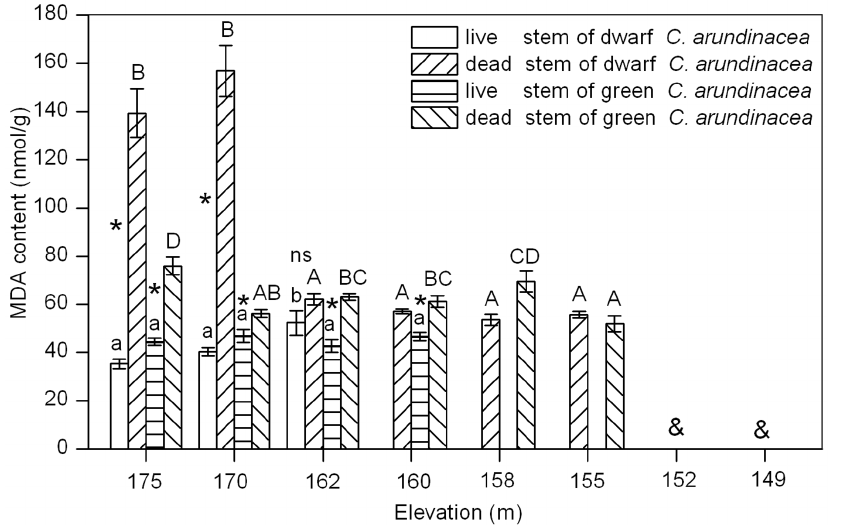
Figure 4. Effects of flooding on MDA content in live stems (LS) and dead stems (DS) of dwarf and green C.arundinacea . Values are mean 6 SE based on six independent assays. Different letters indicate statistical significance ( P , 0.05) according to Duncan’s test, with lowercase for LS and capitals for DS. ns indicates that no significant differences occurred between MDA content of LS and DS, while * indicates that a significant difference occurred between MDA content of LS and DS according to T-test and & indicates that no samples were available at the elevation.